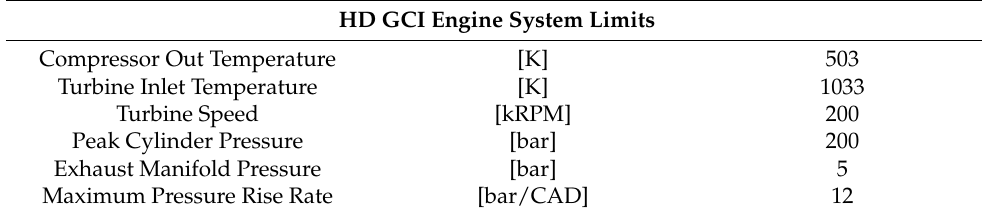
Table 3. Mechanical Engine System